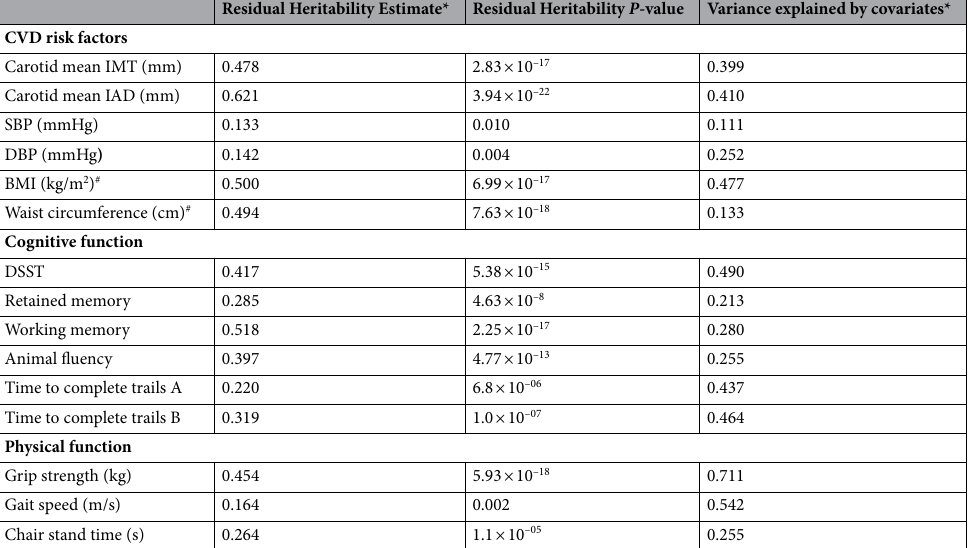
Table 2. Residual Genetic Heritability Estimates. *Residual heritability estimates shown range from 0–1 and demonstrate the proportion of the variance in the measure that is attributed to genetic factors after adjustment for covariates. Whereas, the variance explained by covariates is the proportion of the variance in the measure that is explained by the included covariates. Covariates for each model include: age, age 2 , sex, field centers, height, weight, and whether an individual currently smokes. # Weight and height not included as covariates in BMI model; weight not included as covariate in waist circumference